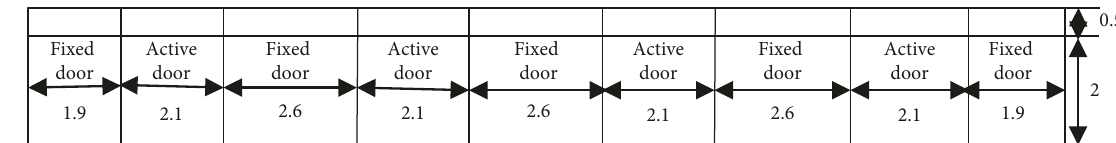
Figure 5: Size of full-height and semiclosed shield door (unit: m).